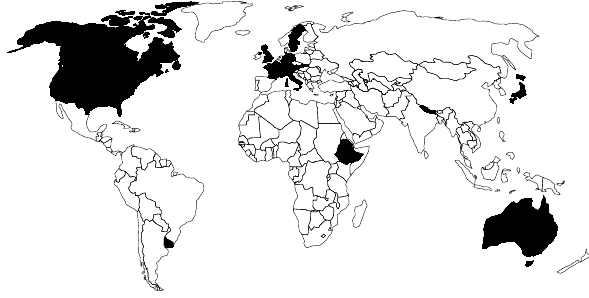
Fig. 1. Map indicating the countries included in the meta-analysis of studies reported in the literature (Level 1 assessment).